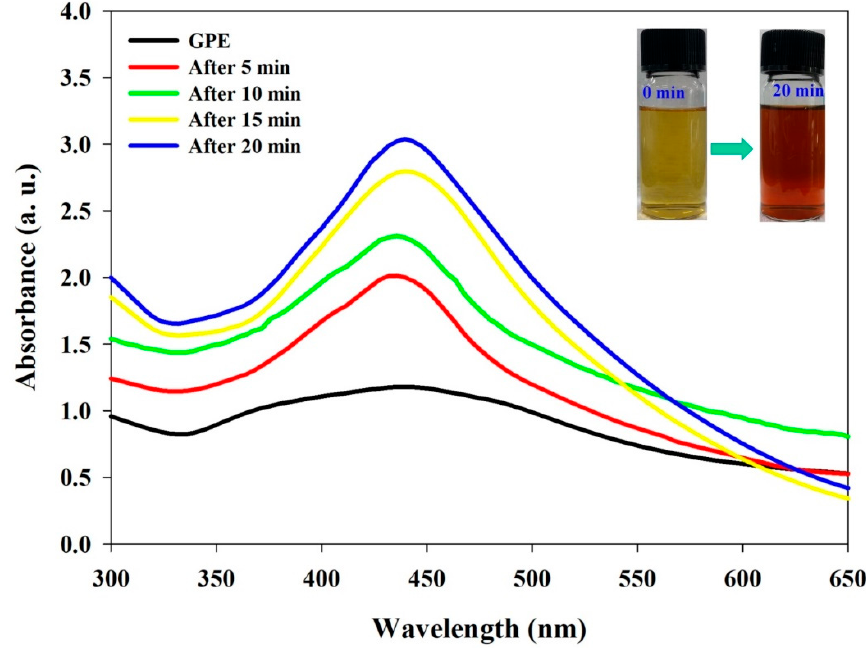
Figure 1. UV–visible absorption spectrum of synthesized grape pomace extract-silver nanoparticles (GPE-AgNPs) at different time intervals.